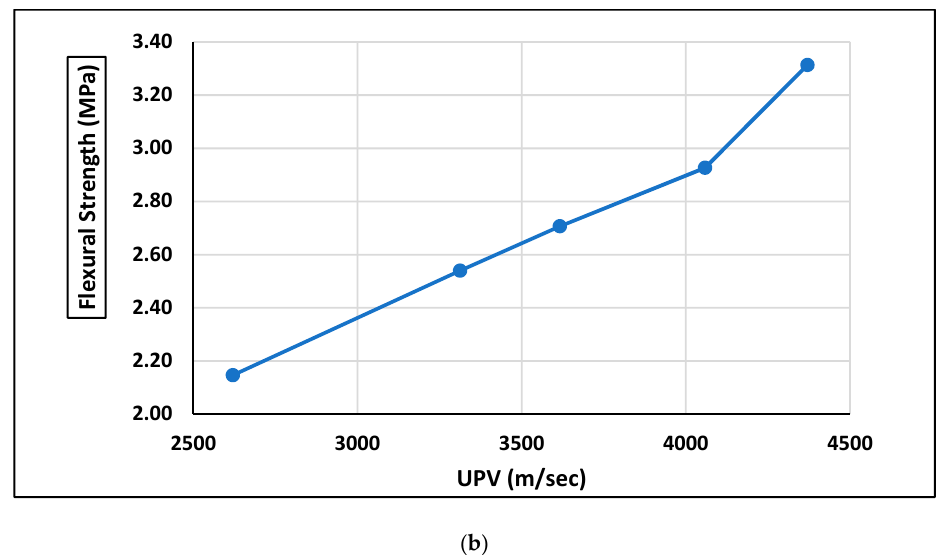
Figure 7. Non-destructive testing (NDT)–destructive testing (DT): ultrasonic pulse velocity (UPV) vs. ( a ) compressive strength and ( b ) flexural strength.